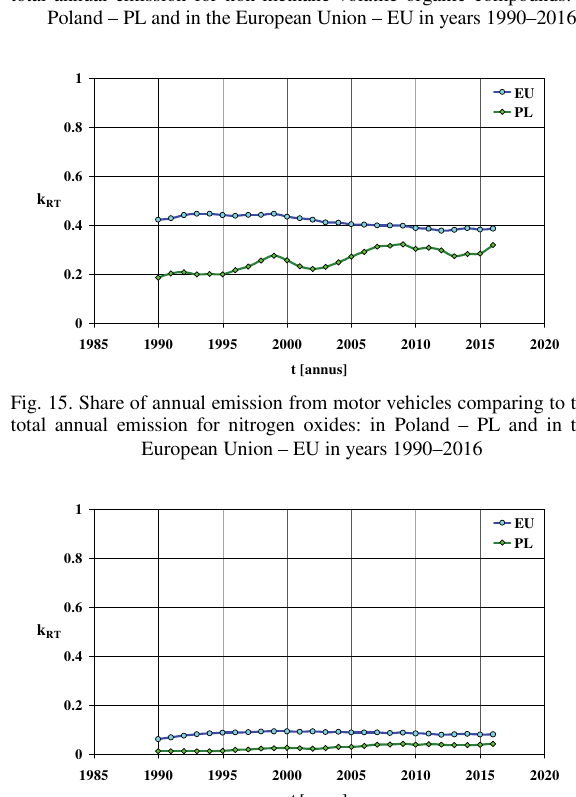
Fig. 14. Share of annual emission from motor vehicles in relation to the total annual emission for non-methane volatile organic compounds: in